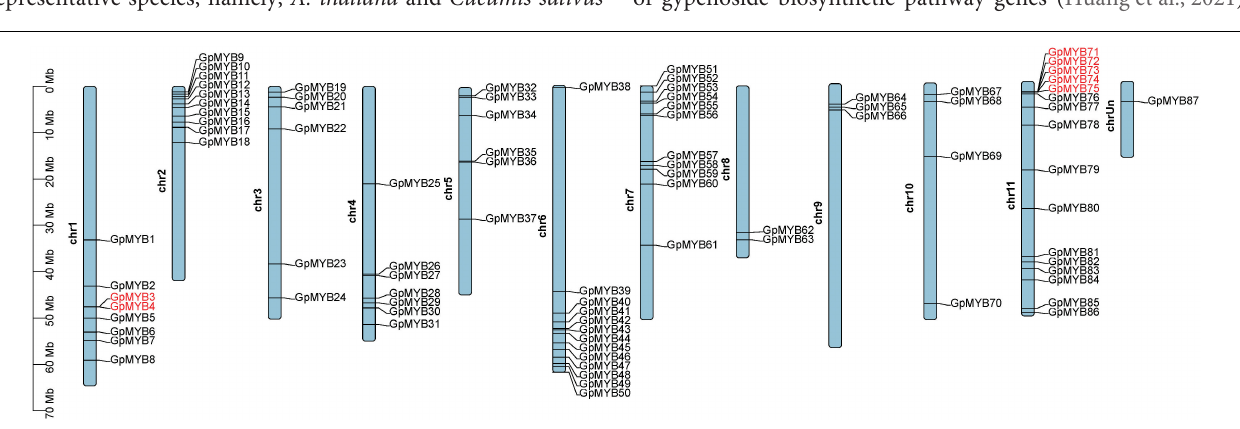
FIGURE 3 | Chromosomal locations of G. pentaphyllum R2R3-MYB genes. Chr 1–11 represent chromosomes 1–11 and chrUn indicates an unanchored linkage group. Chromosomal locations of R2R3-GpMYB genes were mapped based on the G. pentaphyllum genome. The names of genes highlighted in red on chromosomes indicate tandem